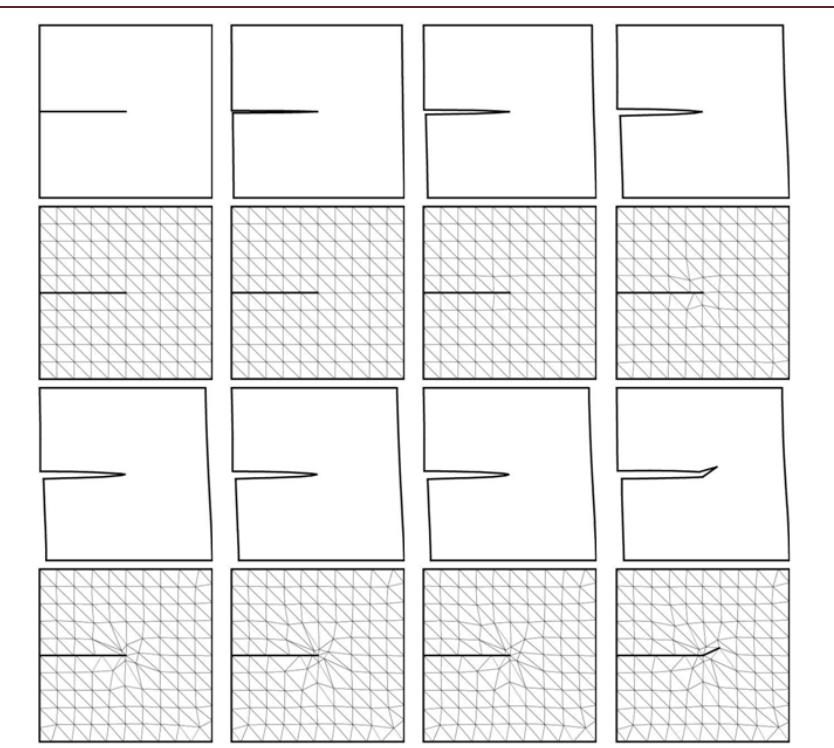
Figure 20: Kinking of a straight crack in mixed mode I & II. Mesh size: L/20 2 . Minimal deformation and modified mesh at 8 time steps. Crack kinking in the last snapshot.